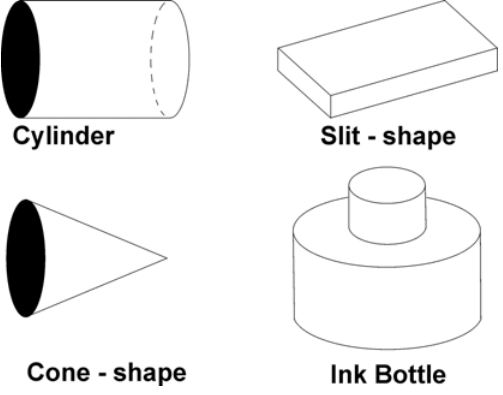
Fig. 3 Pores geometry classification (modified from Kaneko